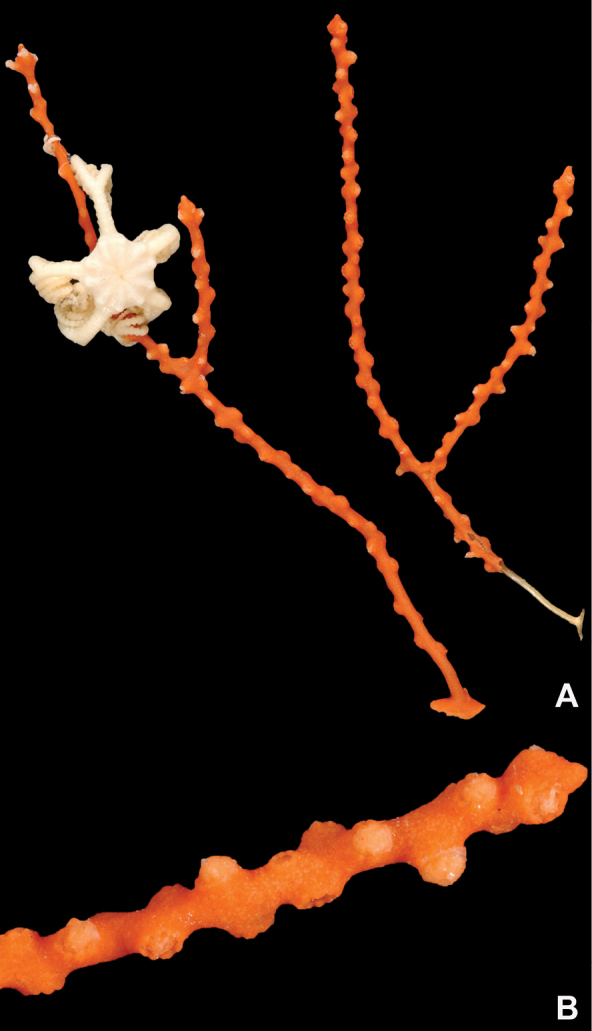
Chromoplexauramarki, SBMNH 265935. A Two colonies, larger of the two (only 7.0 cm tall) with conspicuous brittle star attached. Sclerites did not always consistently match sclerites seen in the species, illustrating variable nature of sclerite forms B Close up of branch tip, showing placement of calyces, color of polyp body and tentacles.